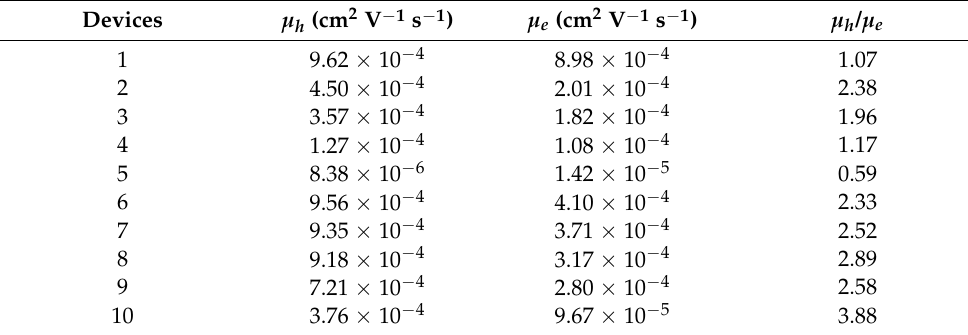
Table 3. Summary of charge carrier mobility calculated by